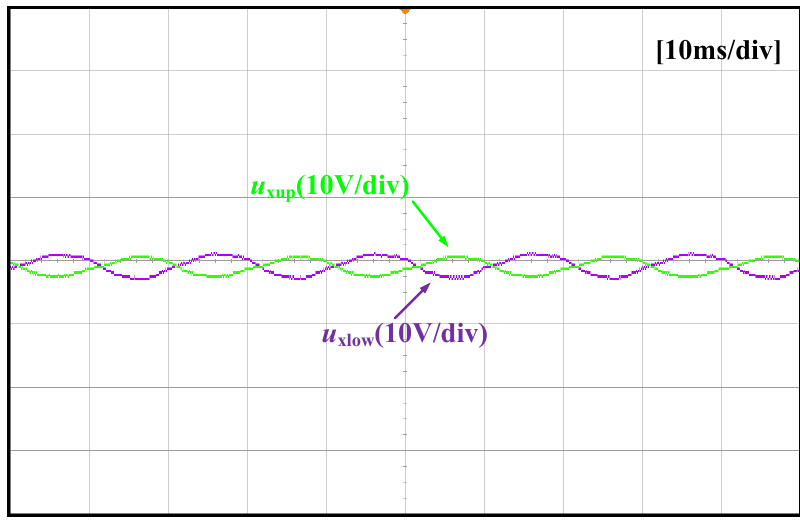
Figure 34. Experimental results of the SCSM capacitor voltages.